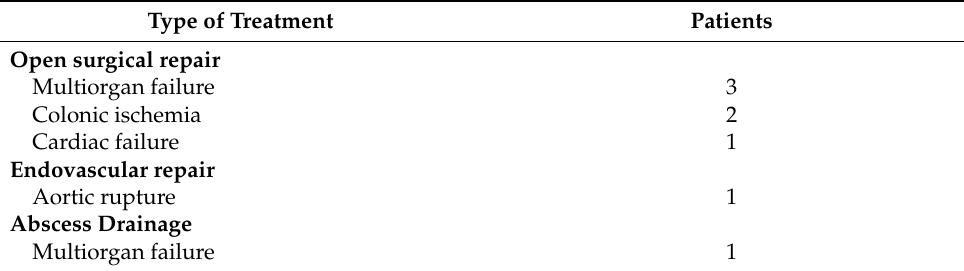
Table 3. Postoperative causes of death according to type of treatment.